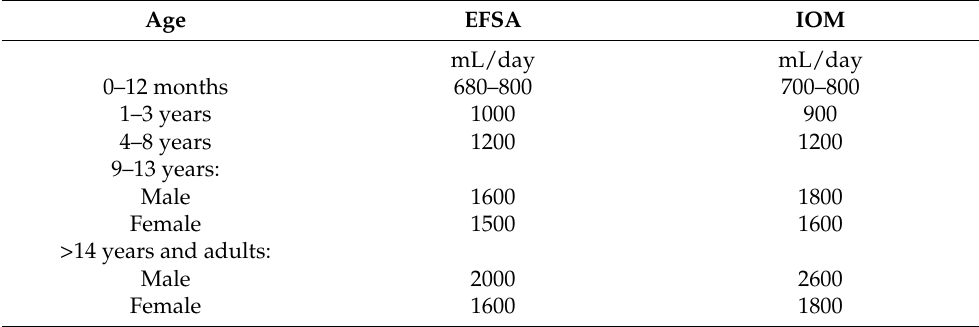
Table 1. Adequate intake for fluids (mL/day) accordingly to EFSA [9] and IOM [10].